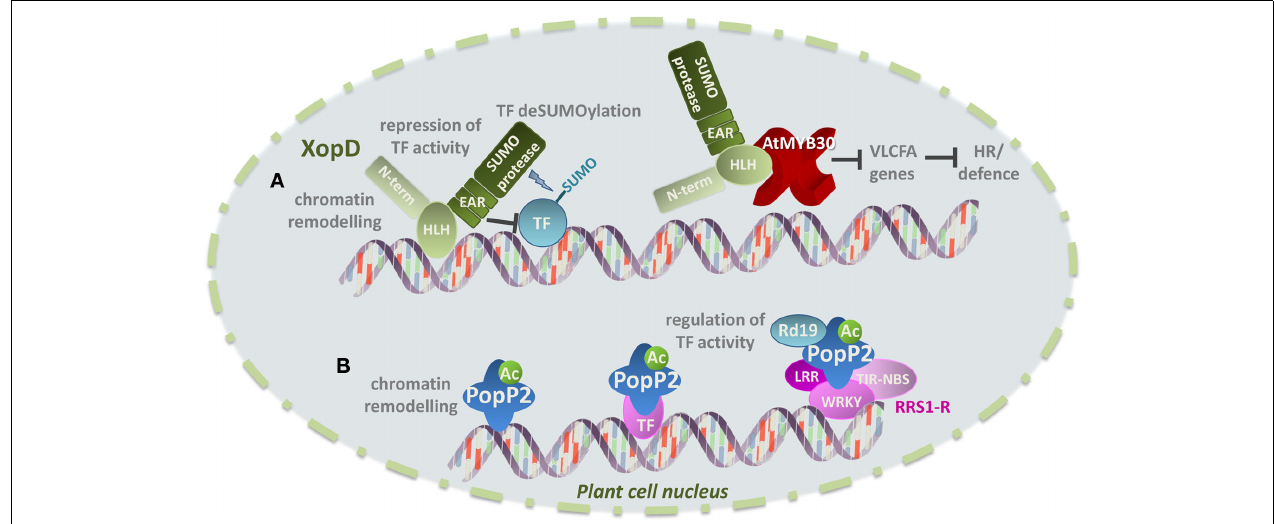
FIGURE 4 | Examples of virulence strategies displayed by bacterial effectors in the plant cell nucleus. (A) XopD from the strain B100 of Xcc is a modular protein with an N-terminal domain of unknown function, a helix-loop-helix domain (HLH), three tandemly repeated transcriptional repressor domain of the EAR type and a C-terminal SUMO protease domain. It has been suggested that XopD DNA-binding activity through its HLH domain may provide access to chromatin and that XopD may thus modulate host transcription by altering chromatin remodeling. XopD may additionally interact with hostTFs and repress their transcriptional activity directly via its EAR domains and/or byTF deSUMOylation. Recent work shows that the